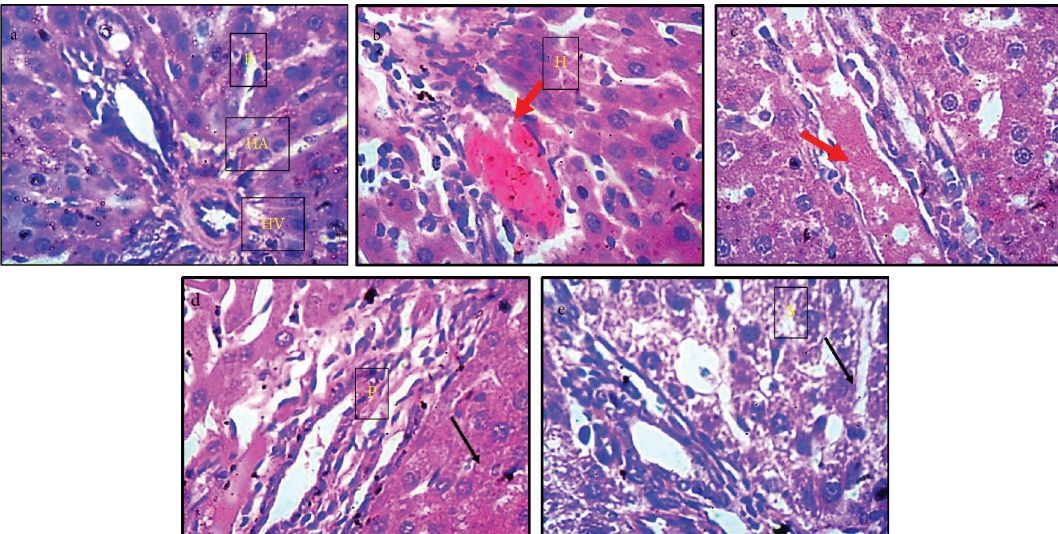
Figure 7: Magnifed views of a liver micromorphological section demonstrated by hematoxylin and eosin staining at high magnifcation ( × 400). Te hepatocytes, sinusoids, and portal triad (hepatic vein, hepatic artery and bile duct) are all visible across the various groups. (a) Normal control (normal rats); (b) NaAr-induced toxicity (sodium arsenate-intoxicated rat); (c) NaAr-Quer (sodium arsenate- intoxicated rat +30mg/kg quercetin treatment); (d) NaAr-Quer +Zn (sodium arsenate-intoxicatedrat +quercetin-Zn complex treat- ment); (e) NaAr-Quer+Fe (sodium arsenate-intoxicatedrat +quercetin-Fe complex treatment). Red arrow � the sinusoids appeared mildly infltrated and some hemorrhage was observed across the profles. Black arrow � the sinusoids appearing normal. B � bileduct; HA � hepatic artery; HV � hepatic vein; H � hepatocytes; P � parenchyma; and S �